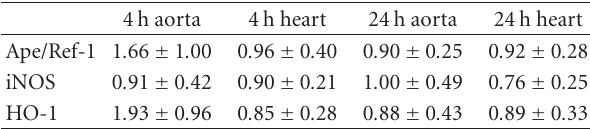
Table 5: Gene expression ratios ( mean ± SD ) in rat aorta and heart tissue due to exposure to DEE as determined by quantitative real- time polymerase chain